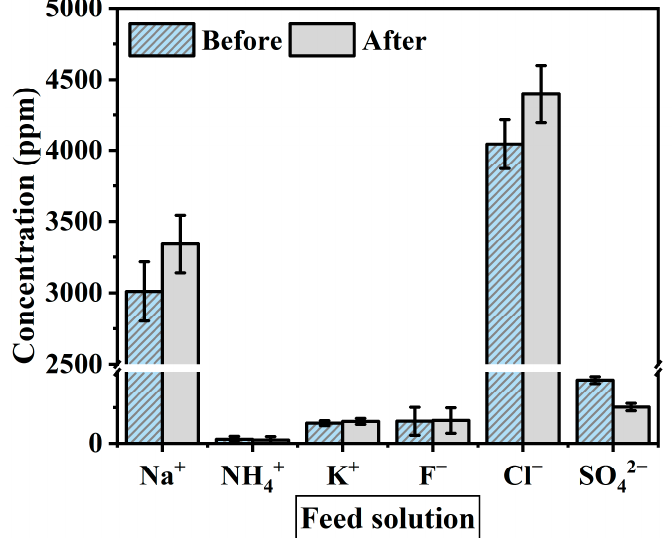
Figure 6. Average ion concentration of feed solution before and after the experiment. The experimental conditions are the FO process (flow rate: 200–500 mL/min) and PAFO process (0.5–1.5 bar) in AL-FS mode and AL-DS mode. Operating time: 1 h; System temperature: 36.5 ± 0.5 °C.